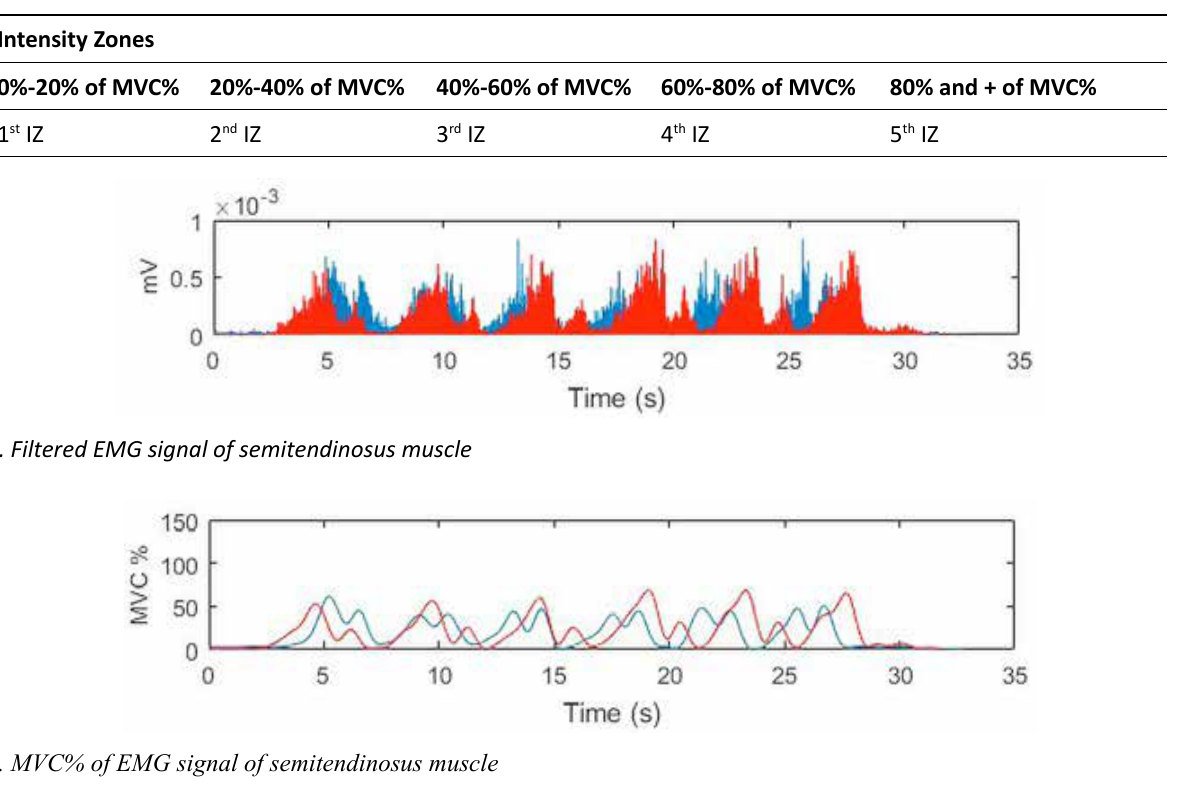
Table 2. Intensity Zones (IZ) determined based on the MVC% values